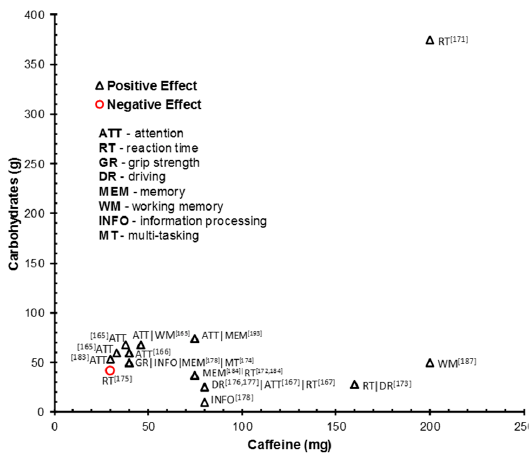
Figure 1. Scatterplot of cognitive performance outcomes (enhanced or impaired) by caffeine and